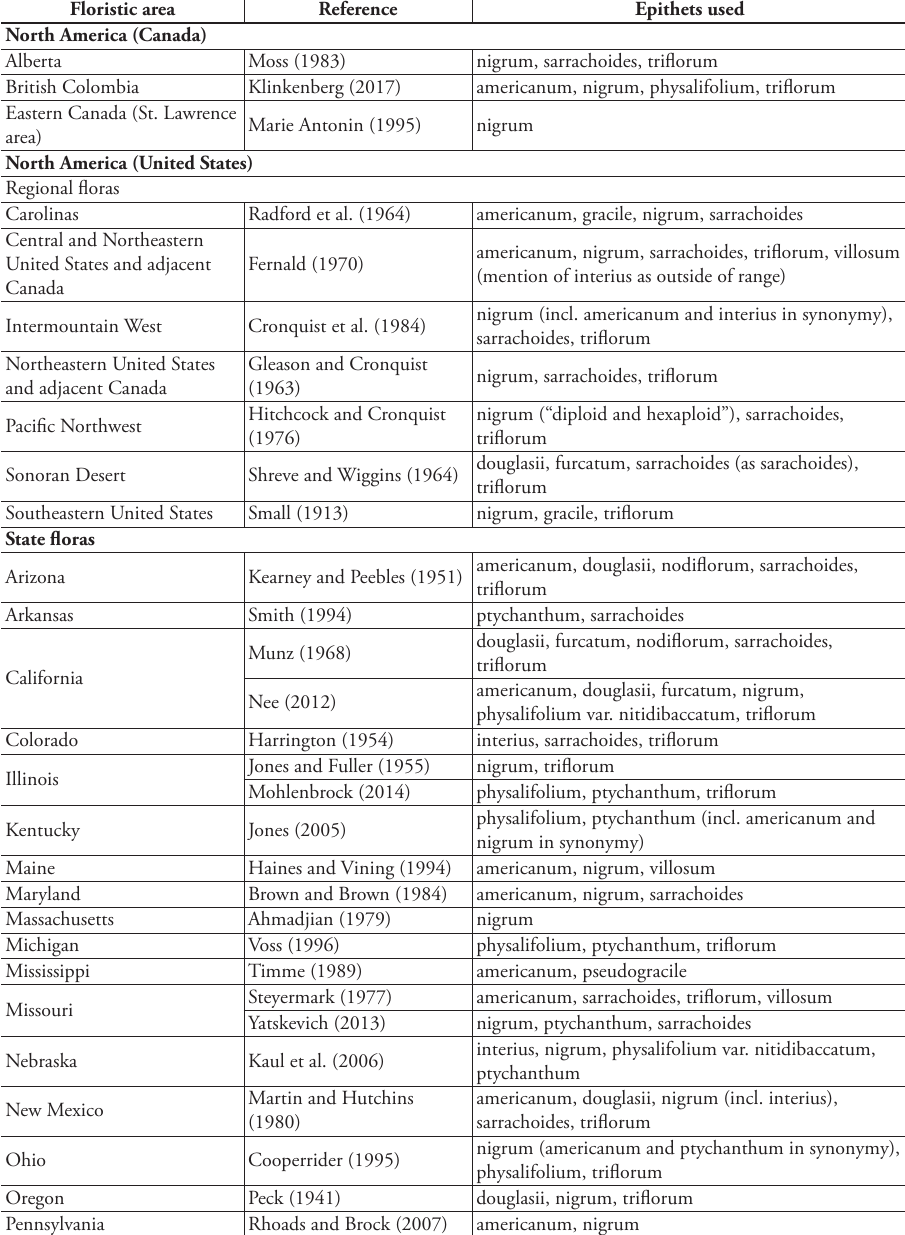
Table 1. Species epithets (the many misspellings e.g., S. sarrachoides as “ S. sarachoides ” and S. ptychan- thum as “ S. ptycanthum ” have been corrected here) used in representative 20 th and early 21 st century regional floras in North and Central America and the Caribbean. For distribution of species we recognise in this treatment occurring in each country and/or state see Tables 4 and 5, the searchable files in the Sup- plementary Material or the dataset on the NHM Data